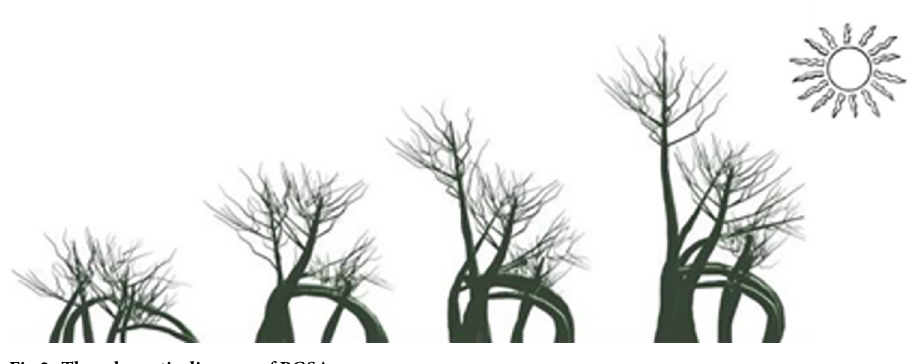
Fig 2. The schematic diagram of